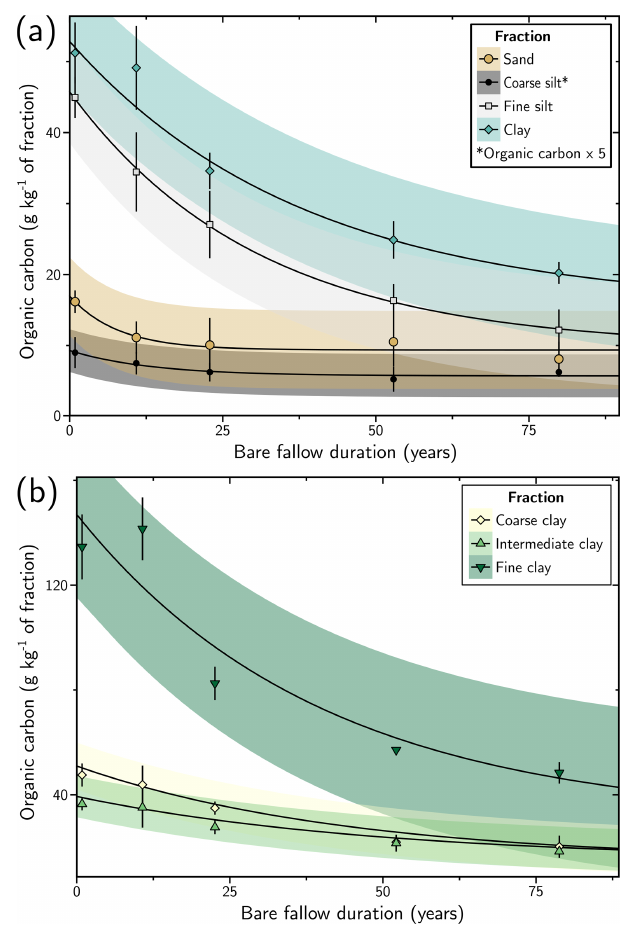
Figure 1. Evolution of the organic carbon content with duration of the long-term bare-fallow experiment for the size fractions stud- ied: (a) sand ( > 50µm), silt (coarse: (20–50)µm, fine: (2–20)µm) and clay ( < 2µm) fractions; (b) coarse ((0.2–2)µm), intermediate ((0.05–0.2)µm) and fine ( < 0.05µm) clay subfractions. The organic content is multiplied by 5 for the coarse silt fraction to clearly see the evolution. The error bars correspond to the standard deviation between the four plot replicates. Where not visible, error bars are smaller than the symbol size. For each fraction, the evolution of the organic carbon content with time is fitted by an exponential decay t function (OC( t ) = OC i · e − MRT + OC p , OC i : intermediate organic carbon content, MRT: mean-residence time and OC p : persistent or- ganic carbon content). The 95% confidence interval obtained from the standard deviation of the function parameters is represented by the coloured